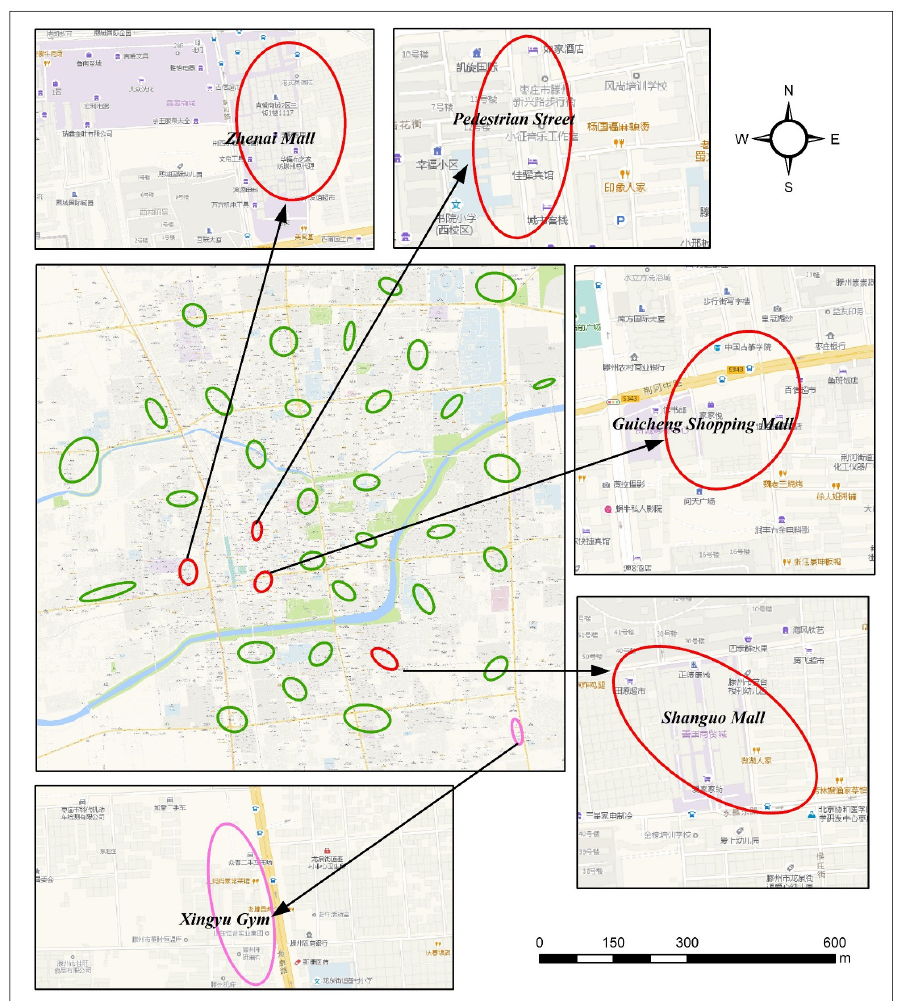
Figure 11. Diverse locations of hot spots in the evening peak period. The green circles indicate the hot spots associated with residential areas, the red circles indicate the hot spots associated with shopping malls, and the prink circle indicate the hot spots associated with entertainment.